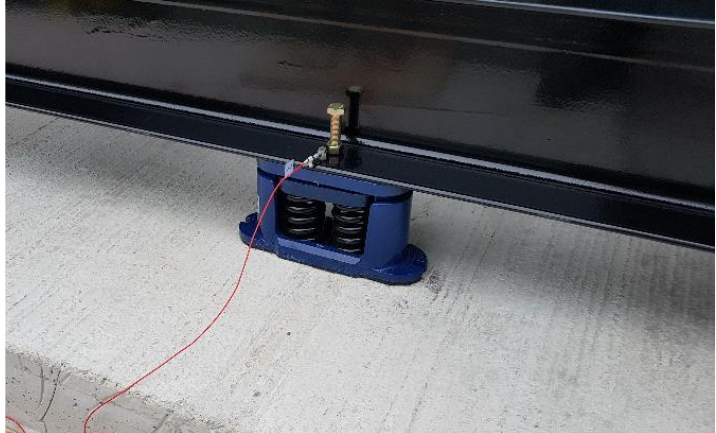
Figure 2. Image of vibration isolator [20].